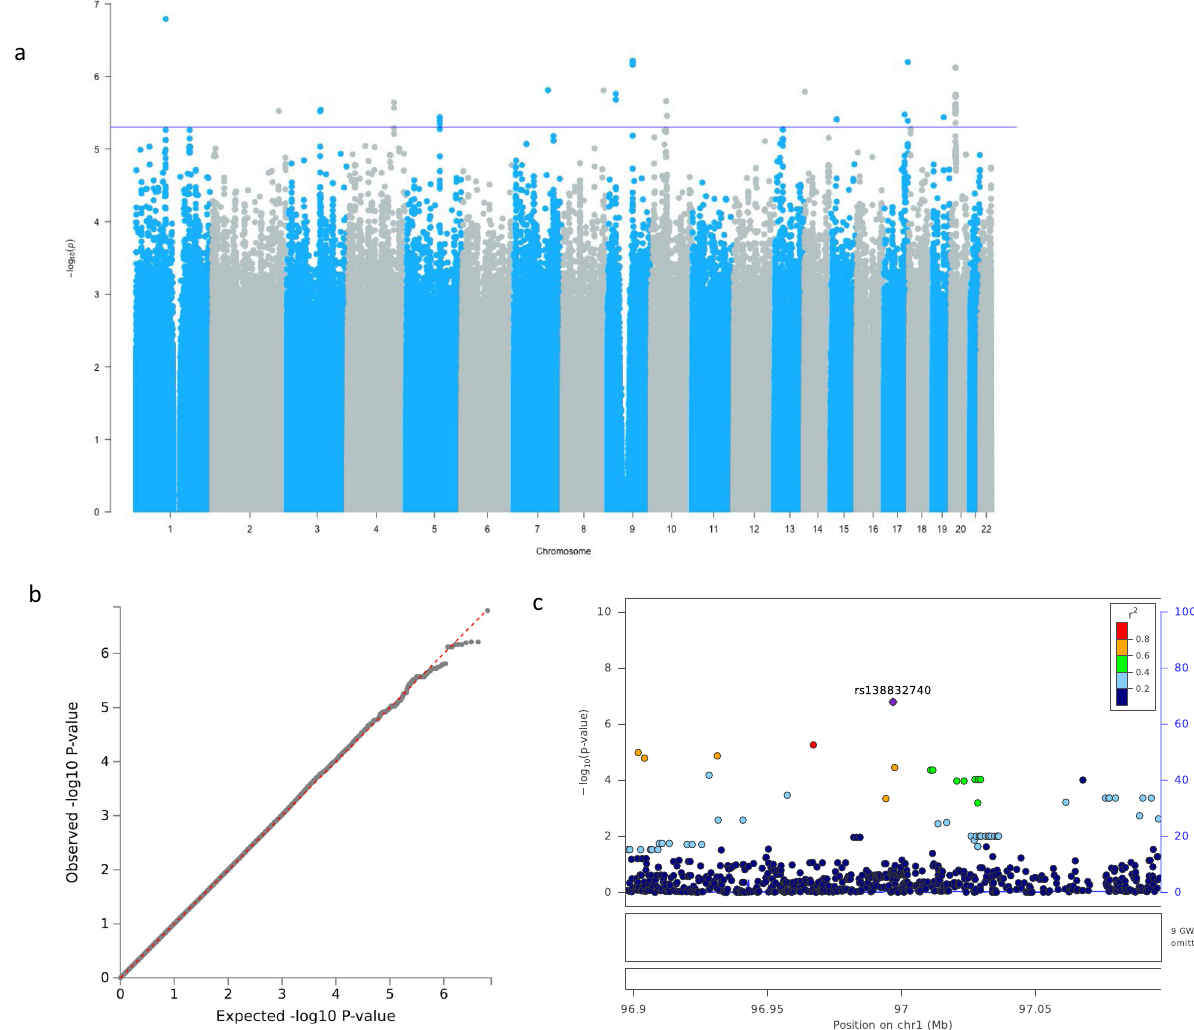
Fig. 5 Genome-wide and suggestive associations for total cognition score. a Manhattan plot. No genome-wide or near genome-wide signi fi cant signals. Suggestive cut-off 5 × 10 − 6 shown by a blue line. b QQ-plot ( λ = 1.00) for association summary statistics. c Locus zoom plot for rs138832740. LD values are based on a South African LD